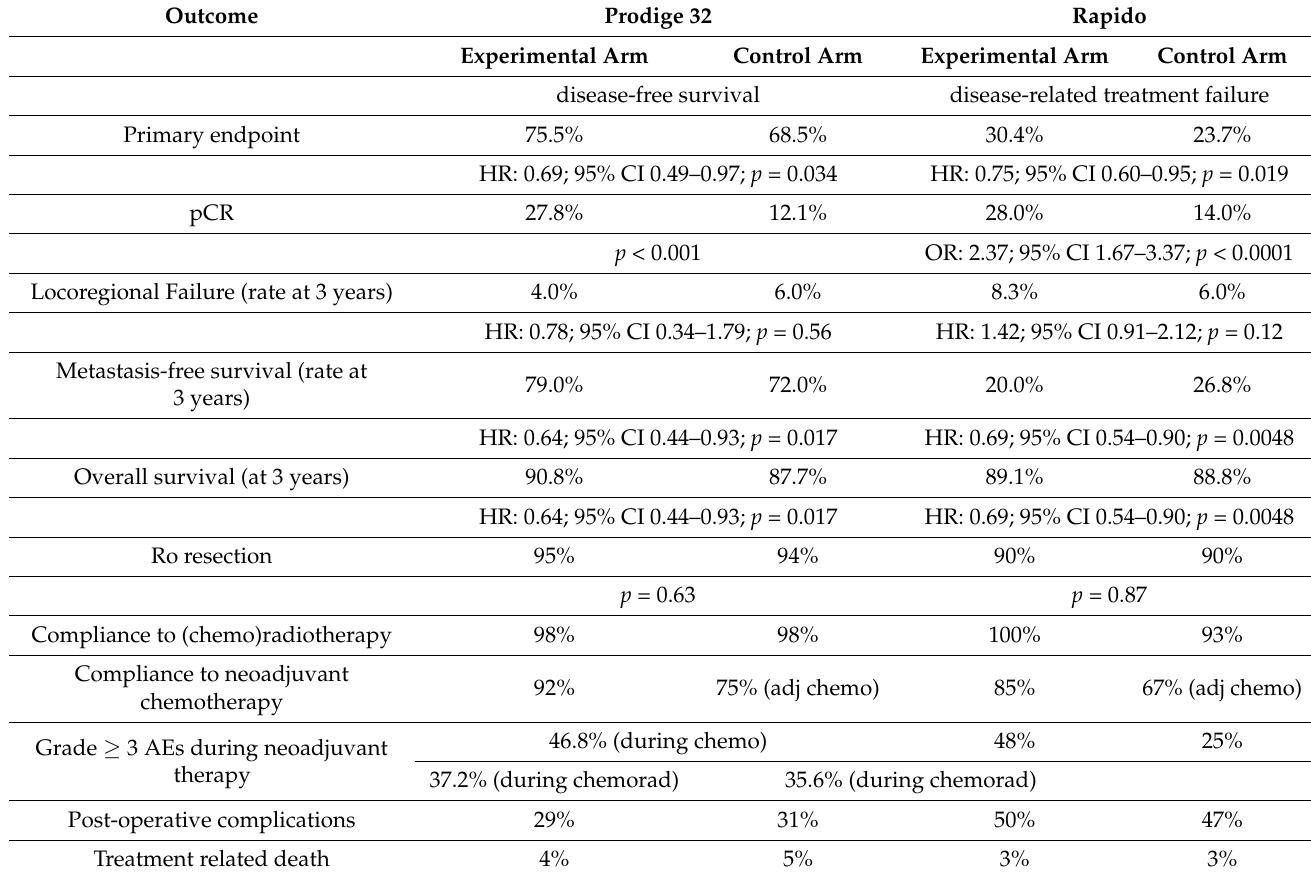
Table 1. Safety and efficacy data from PRODIGE 23 and RAPIDO